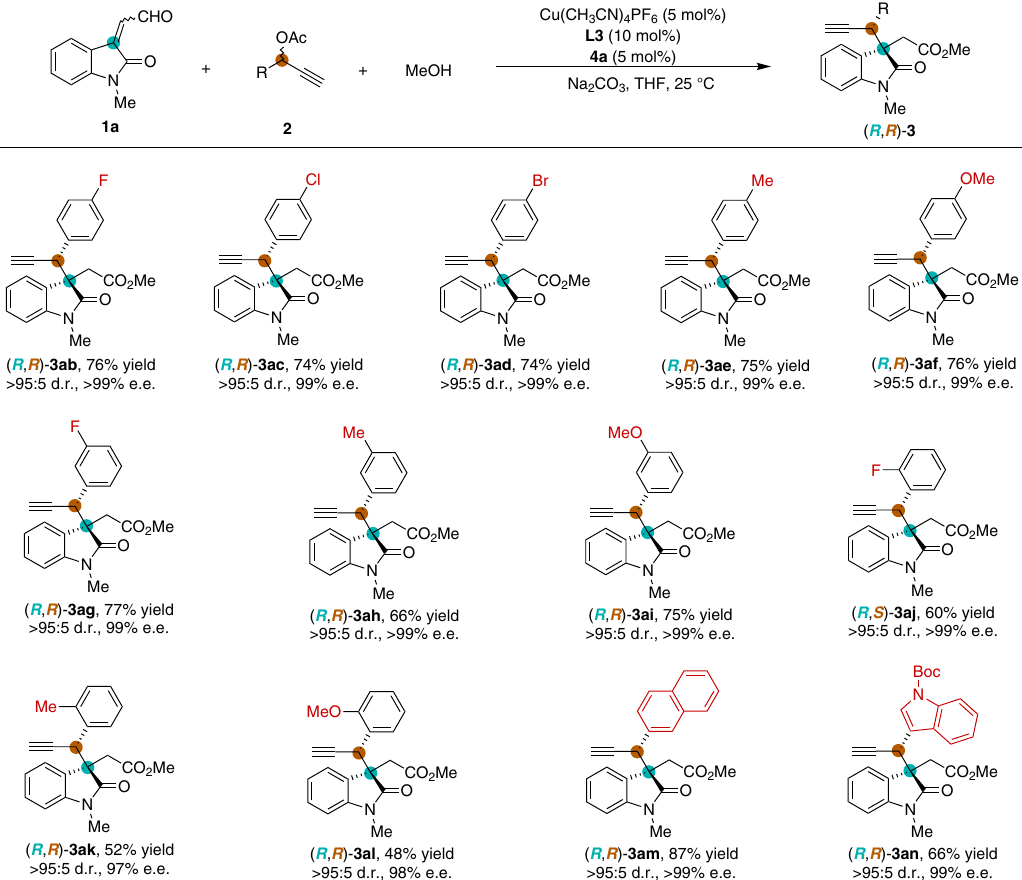
Fig. 3 Substrate scope of propargylic acetates. Reaction conditions: Cu(CH 3 CN) 4 PF 6 (5 mol%) and pyridine bis(oxazoline) ligand L3 (10 mol%) were stirred in THF (0.5 mL) at 25 °C for 1 h, then NHC precatalyst 4a (5 mol%), 1a (0.15 mmol), 2 (0.1 mmol), MeOH (0.5 mmol), Na 2 CO 3 (0.1 mmol) and THF (0.5 mL) were added to the reaction mixture and stirred for 12 h under N 2 . Diastereomeric ratio (d.r.) was determined by 1 H NMR spectroscopic analysis. Isolated yields. The enantiomeric excess (e.e.) was determined by